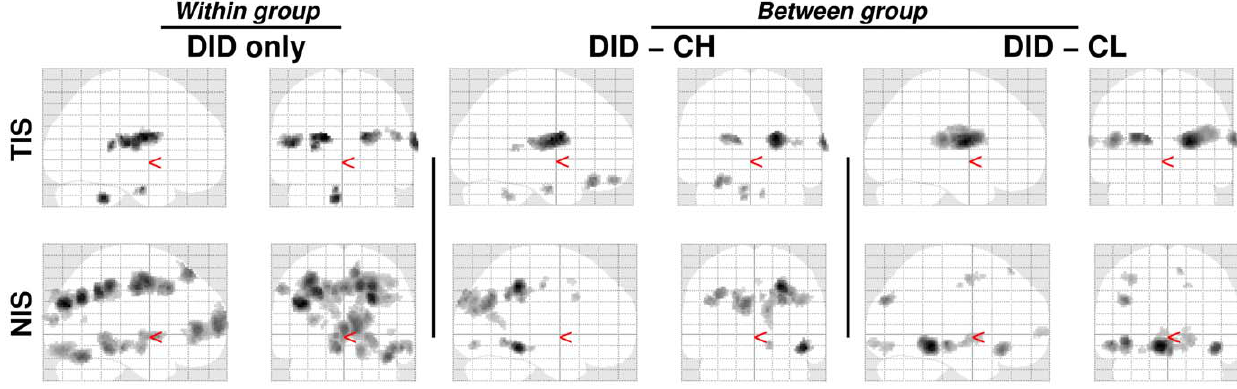
Figure 2. ‘‘Glass brain’’ renderings showing the dissociative identity state main effects, both for the trauma-related identity state (TIS) and for the neutral identity state (NIS), for the dissociative identity disorder (DID) group (left) and the comparison of this group to the high (middle) and low (right) fantasy prone DID simulating controls (CH and CL respectively). See Table 2 for the specific areas.